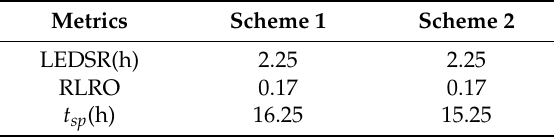
Table 15. The response ability of the system.